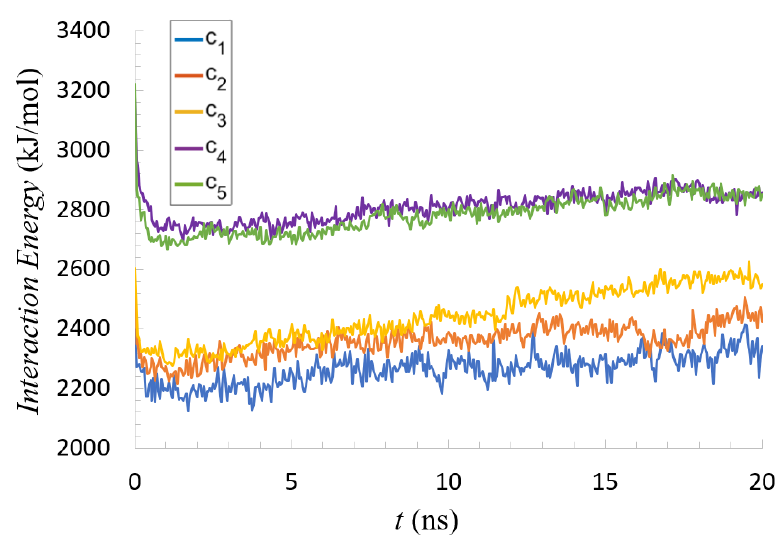
Figure 4. Interaction energies (per one mucin molecule originating across all simulation runs) as a function of